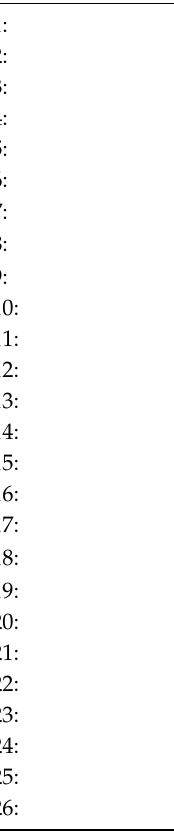
The index table of IGSMSpace T ( K , C ) , in which C = { c } and C denotes the ID